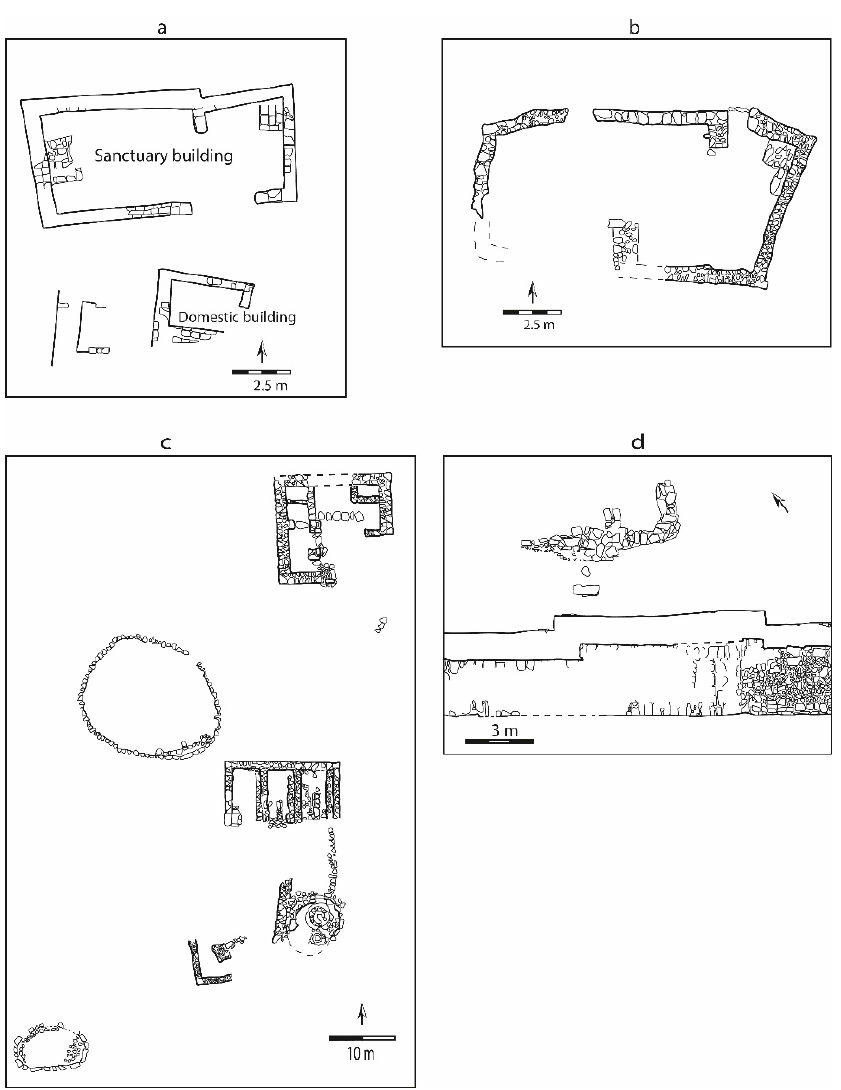
Figure 2. ( a ): Tell Damiyah Phase VII (after Petit and Kafafi 2016, Fig. 5); ( b ): WT-13 Stratum IIB (after Daviau 2017, Fig. 3.26); ( c ): Horvat Qitmit (after Beit-Arieh 1995, Fig. 1.6); ( d ): ‘Ein Haseva favissa (after Ben-Arieh 2011, Plan